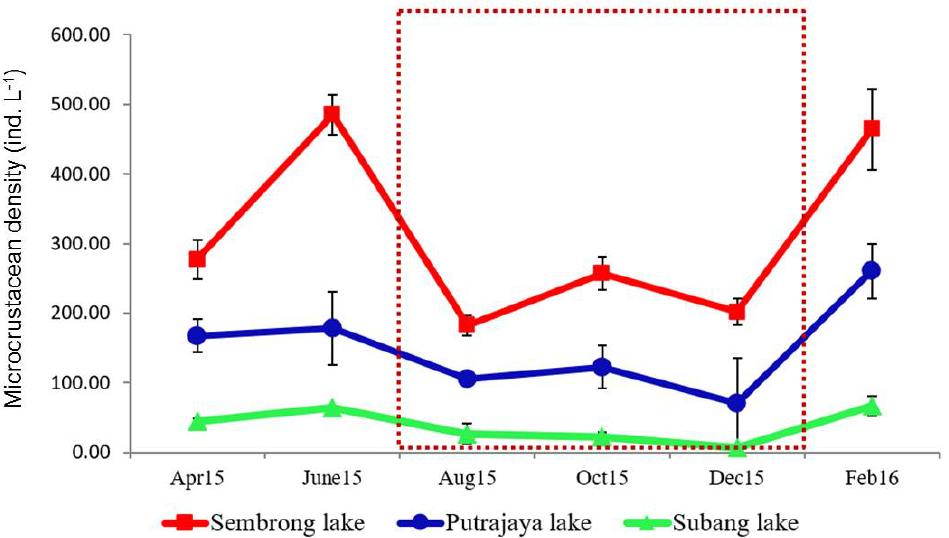
Figure 5. Monthly mean microcrustacean densities (ind. L −1 ) in Sembrong, Putrajaya and Subang lakes during the study period. Rectangular box (dashed line) indicates significantly low ( p < 0.05) microcrustacean density during wet months. Vertical bars indicate standard error of the means ( n = 18). Table 4. Pairwise R-statistical values and significant levels ( p ) for two-way analysis of similarities (ANOSIM) test on microcrustacean densities in di ff erent lakes with Global R = 0.85. Group (Lakes) R Significance Level